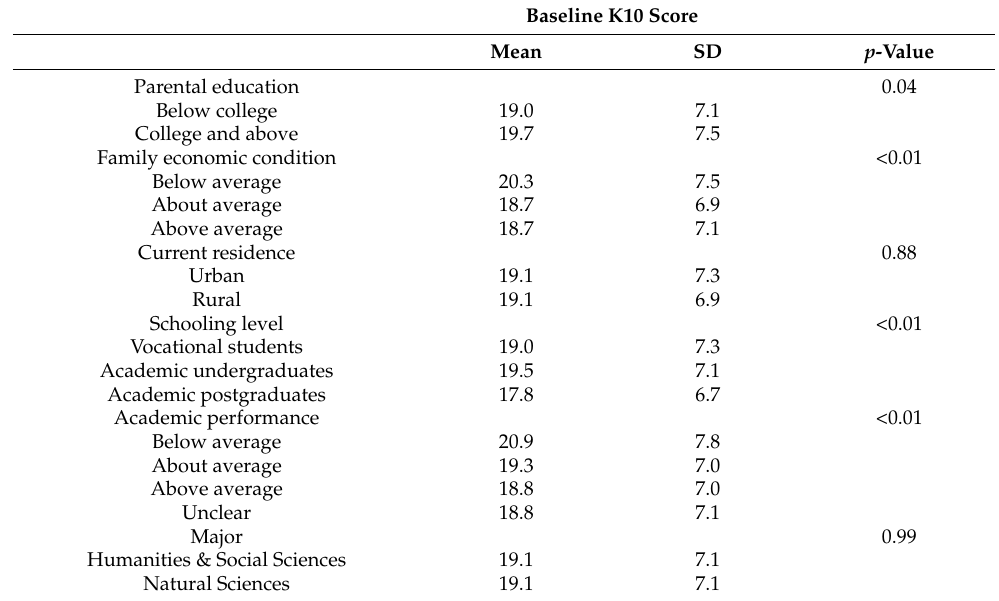
Table A2. Baseline level of psychological distress across groups as defined by family and education